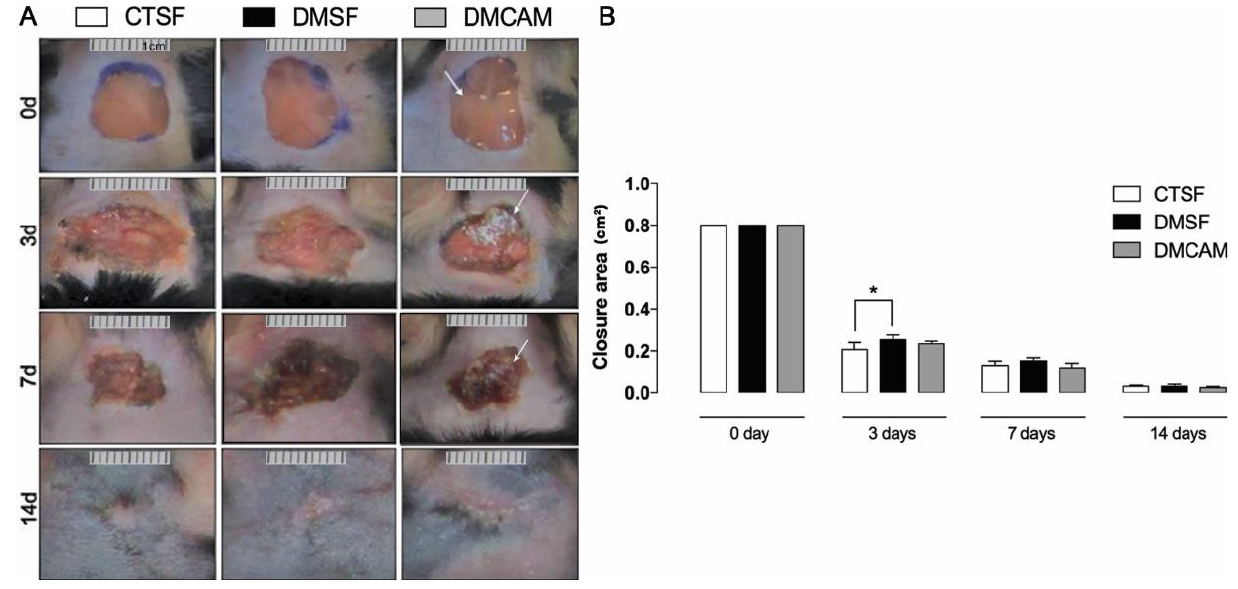
Figure 2. ( A ) representative images of the healing process were monitored at day 0, 3, 7, 14 after injury. ( B ) Wound areas were quantified and expressed as closure area (cm 2 ), and area analyzed with ImageJ ® of normoglycemic animal groups submitted to topical treatment with 0.9% saline solution (CTSF group); of hyperglycemic animals submitted to topical treatment with 0.9% saline solution (DMSF group); and hyperglycemic animals submitted to a topical solution with chitosan-alginate membranes (DMCAM group) on post-wound days 3, 7 and 14. Arrows indicate the presence of alginate and chitosan membranes (CAM) in the wound bed. * Groups statistically different ( p < 0.05), compared by One-way ANOVA, followed by a Tukey multiple comparison test.